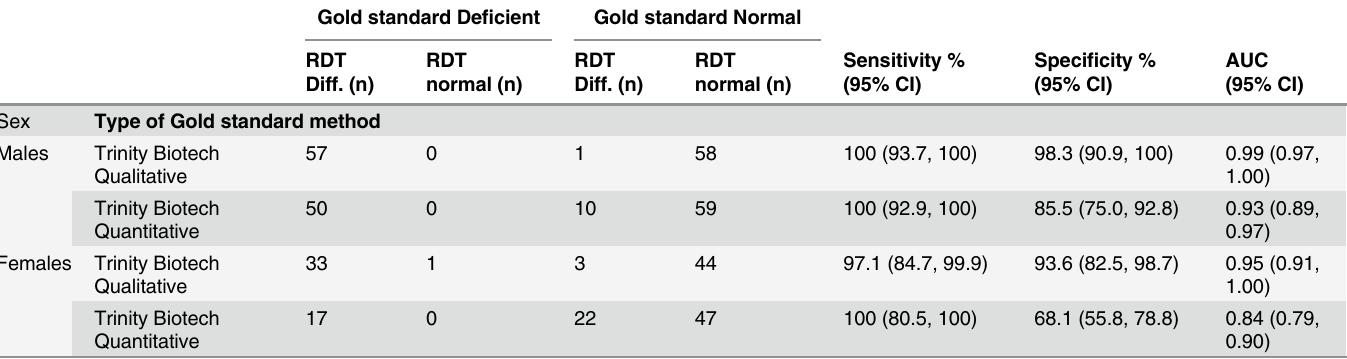
Table 3. Diagnostic performance of CareStart G6PD RDT by gender compared to Trinity Biotech Quantitative and Qualitative methods for G6PD deficiency screening.